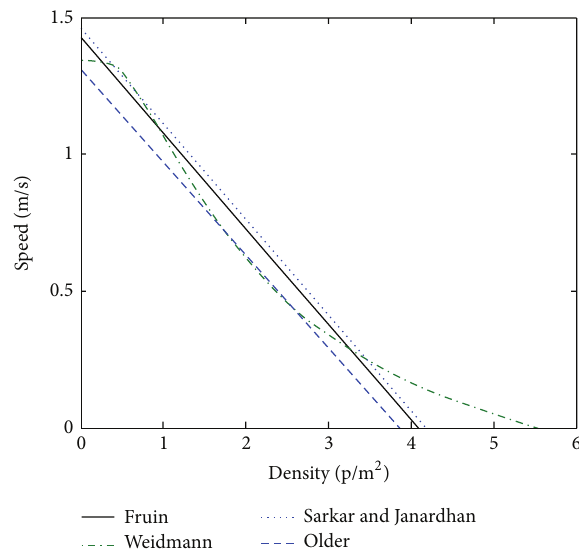
Figure 1: The diagram for the estimated speed-density relations for unidirectional pedestrian traffic flow in empirical studies. Fruin [20], Sarkar and Janardhan [21], and Older [22] used a linear speed- density relation, while Weidmann [23] used a double S-bended